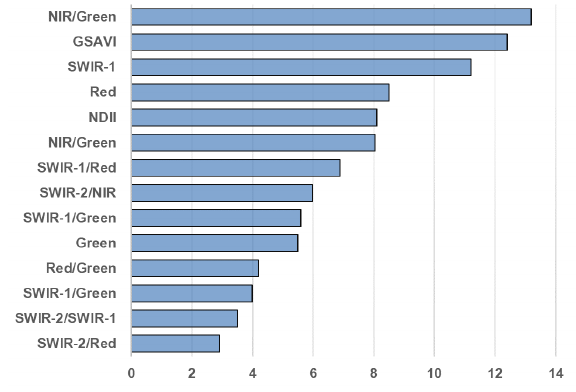
Figure 3. Relative importance score of feature in [34].